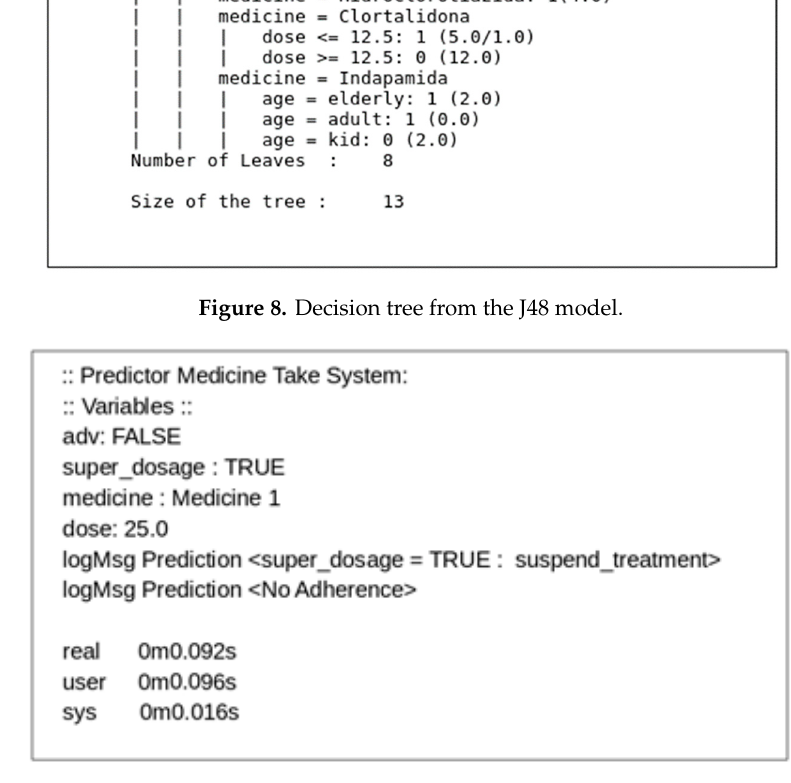
Figure 8. Decision tree from the J48 model.